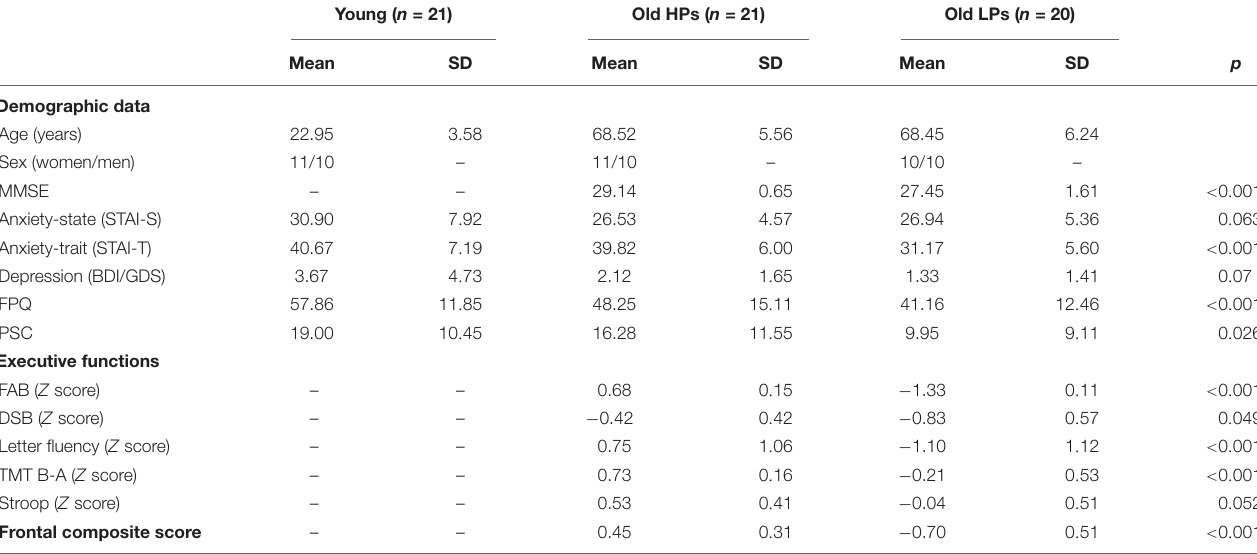
TABLE 1 | Demographic characteristics and performances on executive functions